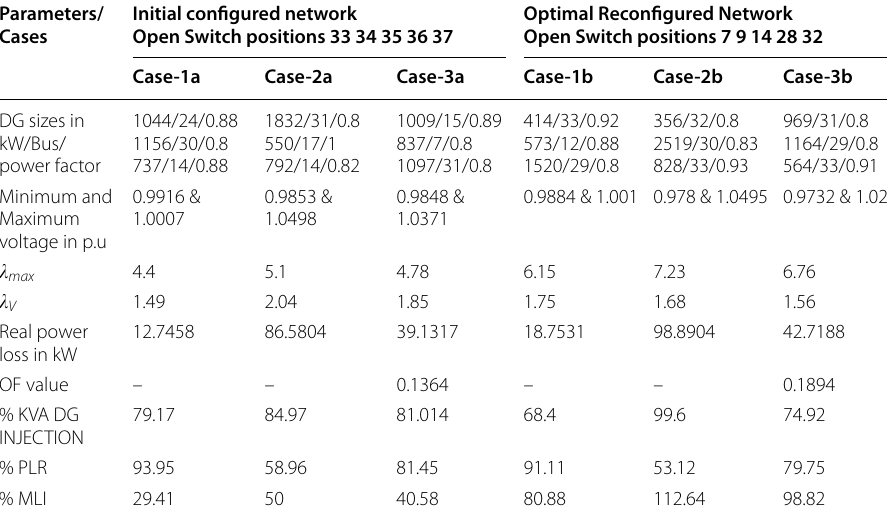
Table 3 Simulation results of 33 bus system for scenario-1 Parameters/